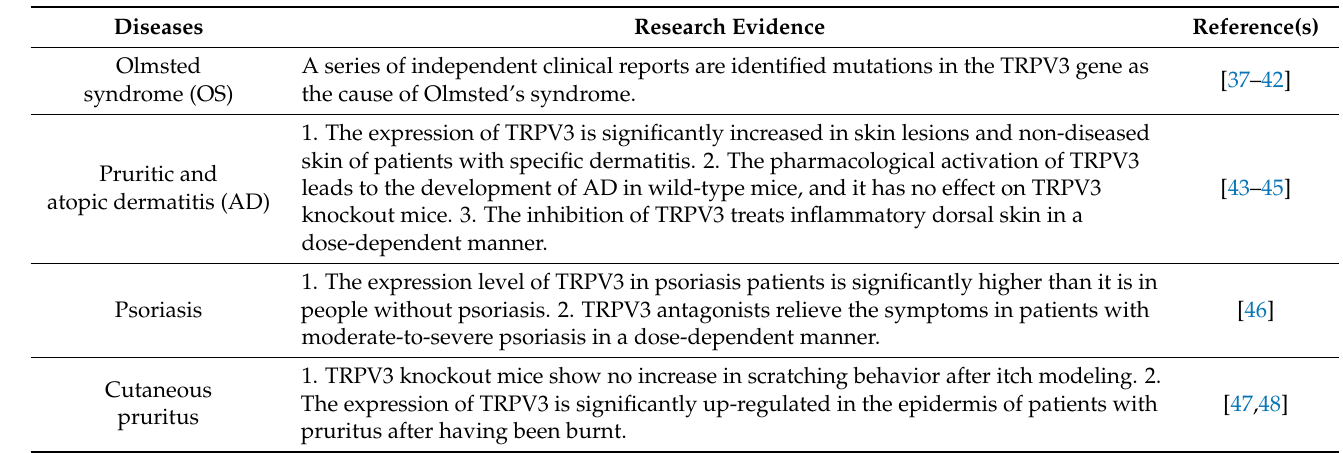
Table 1. TRPV3 and Table 1. TRPV3 and diseases.